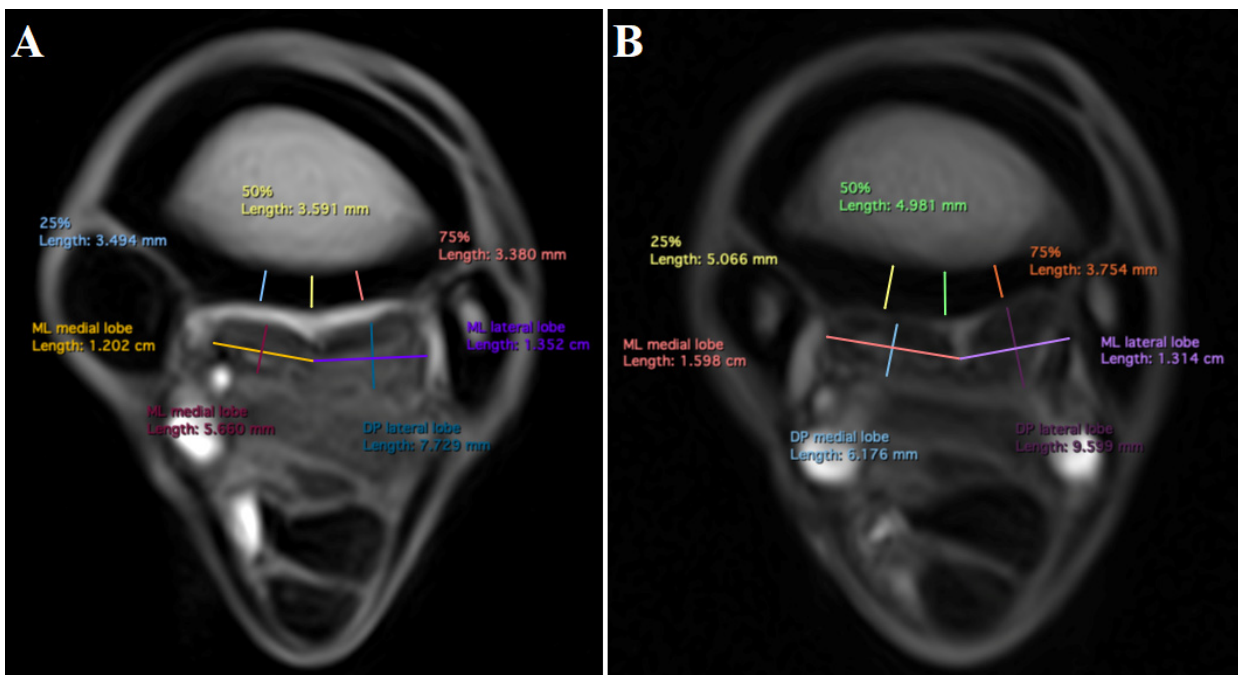
Figure 2. Midline sagittal image from the pilot scan, depicting how the levels were set at 2, 3, 5, and 7 cm distal to the carpometacarpal joint, perpendicular to the suspensory ligament.